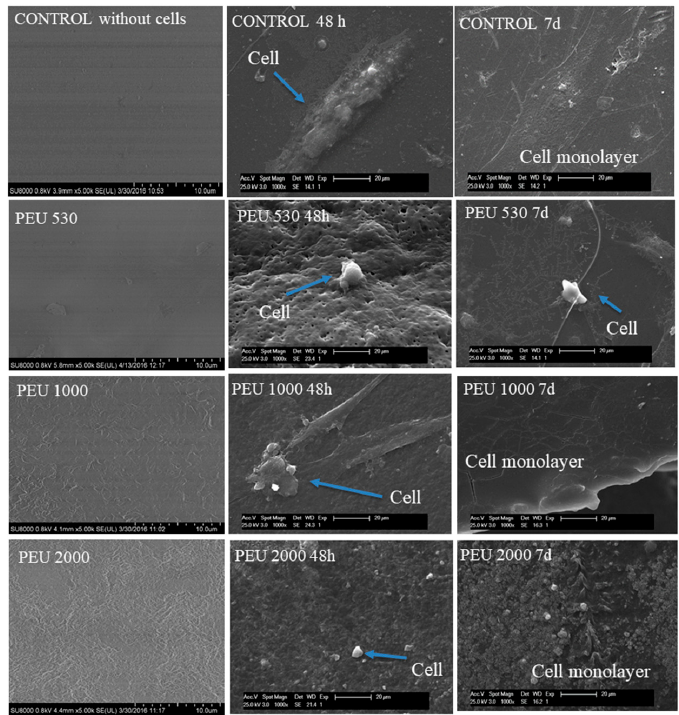
Figure 8. SEM of cell adhesion at 48 h and 7 days on the PEUs.